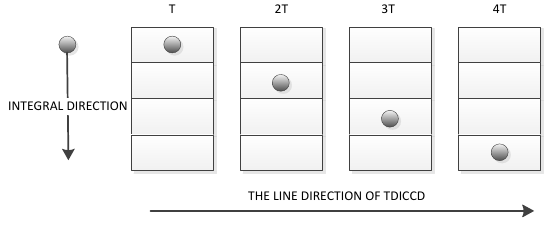
Figure 1. Principle of the